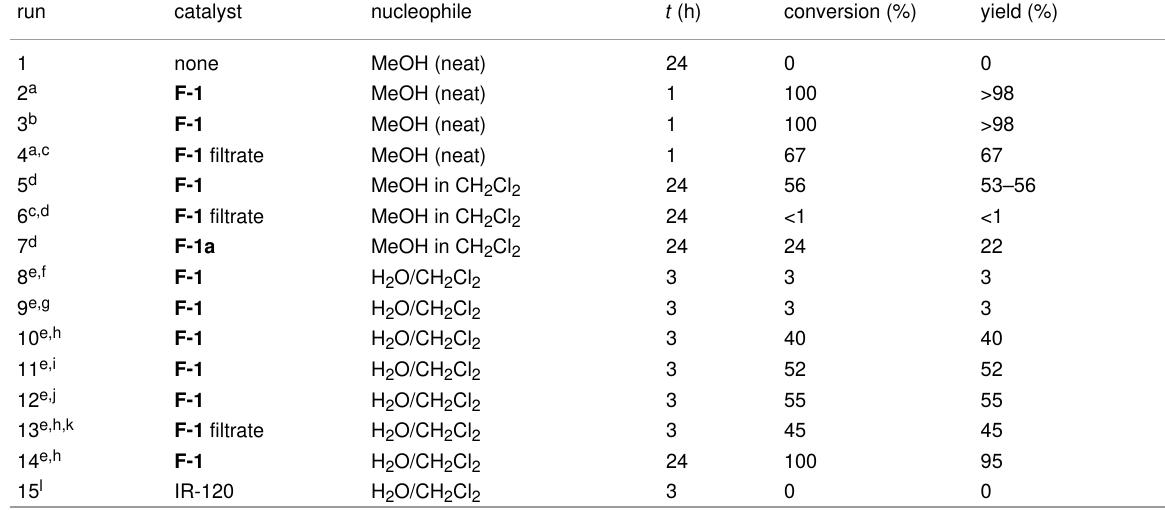
Table 1: The ring opening of styrene oxide ( 2 ) by MeOH or H 2 O, promoted by uncrystallized F-1 or F-1 with an F-1a phase at room temperature. run catalyst